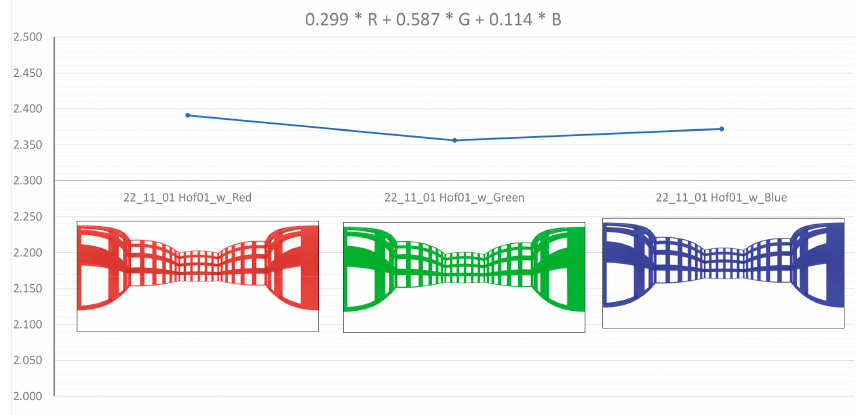
Figure 8. Measurement method “Grayscale DBX M × N ( m × m ) (shifting boxes)” with the grayscale conversion adapted to the perception of brightness (see Formula (13)) applied to a red-tinted ( left ; D B = 2.391 with a correlation of 0.998568), green-tinted ( center ; D B = 2.356 with a correlation of 0.998986), and blue-tinted façade ( right ; D B = 2.372 with a correlation of 0.998868). Closed and partially open courtyards showed differences even if the opening was small, with the former resulting in higher box-counting dimensions than the latter (see Figure 9).